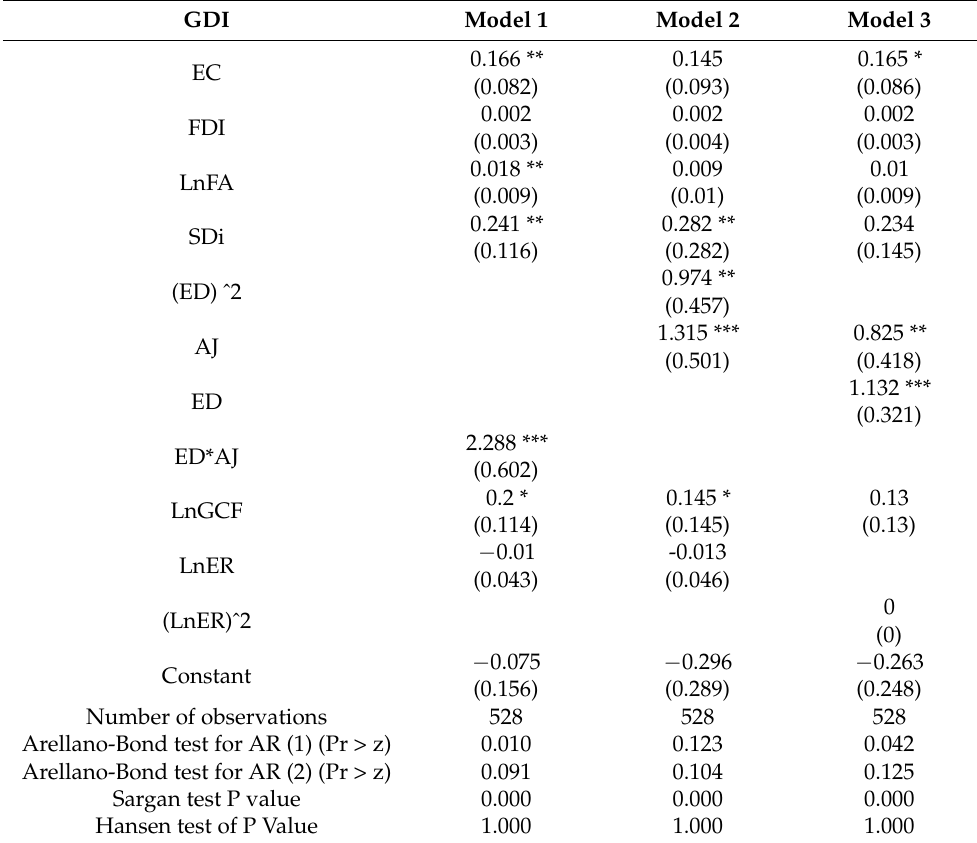
Table 7. Results of Generalised Method of Moments 2000–2020. Dependent variable: Gender Development Index (United Nations Reports). 24 Asian